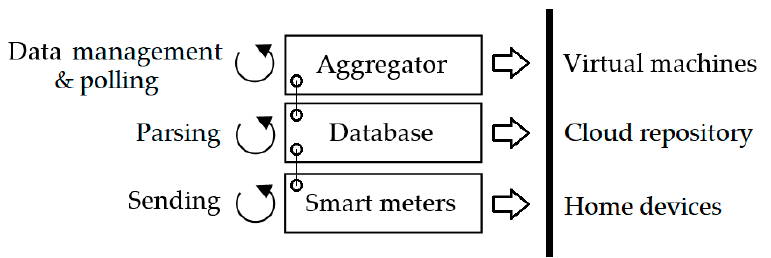
Figure 3. Communication between aggregator and smart meters, a database interfaces them.